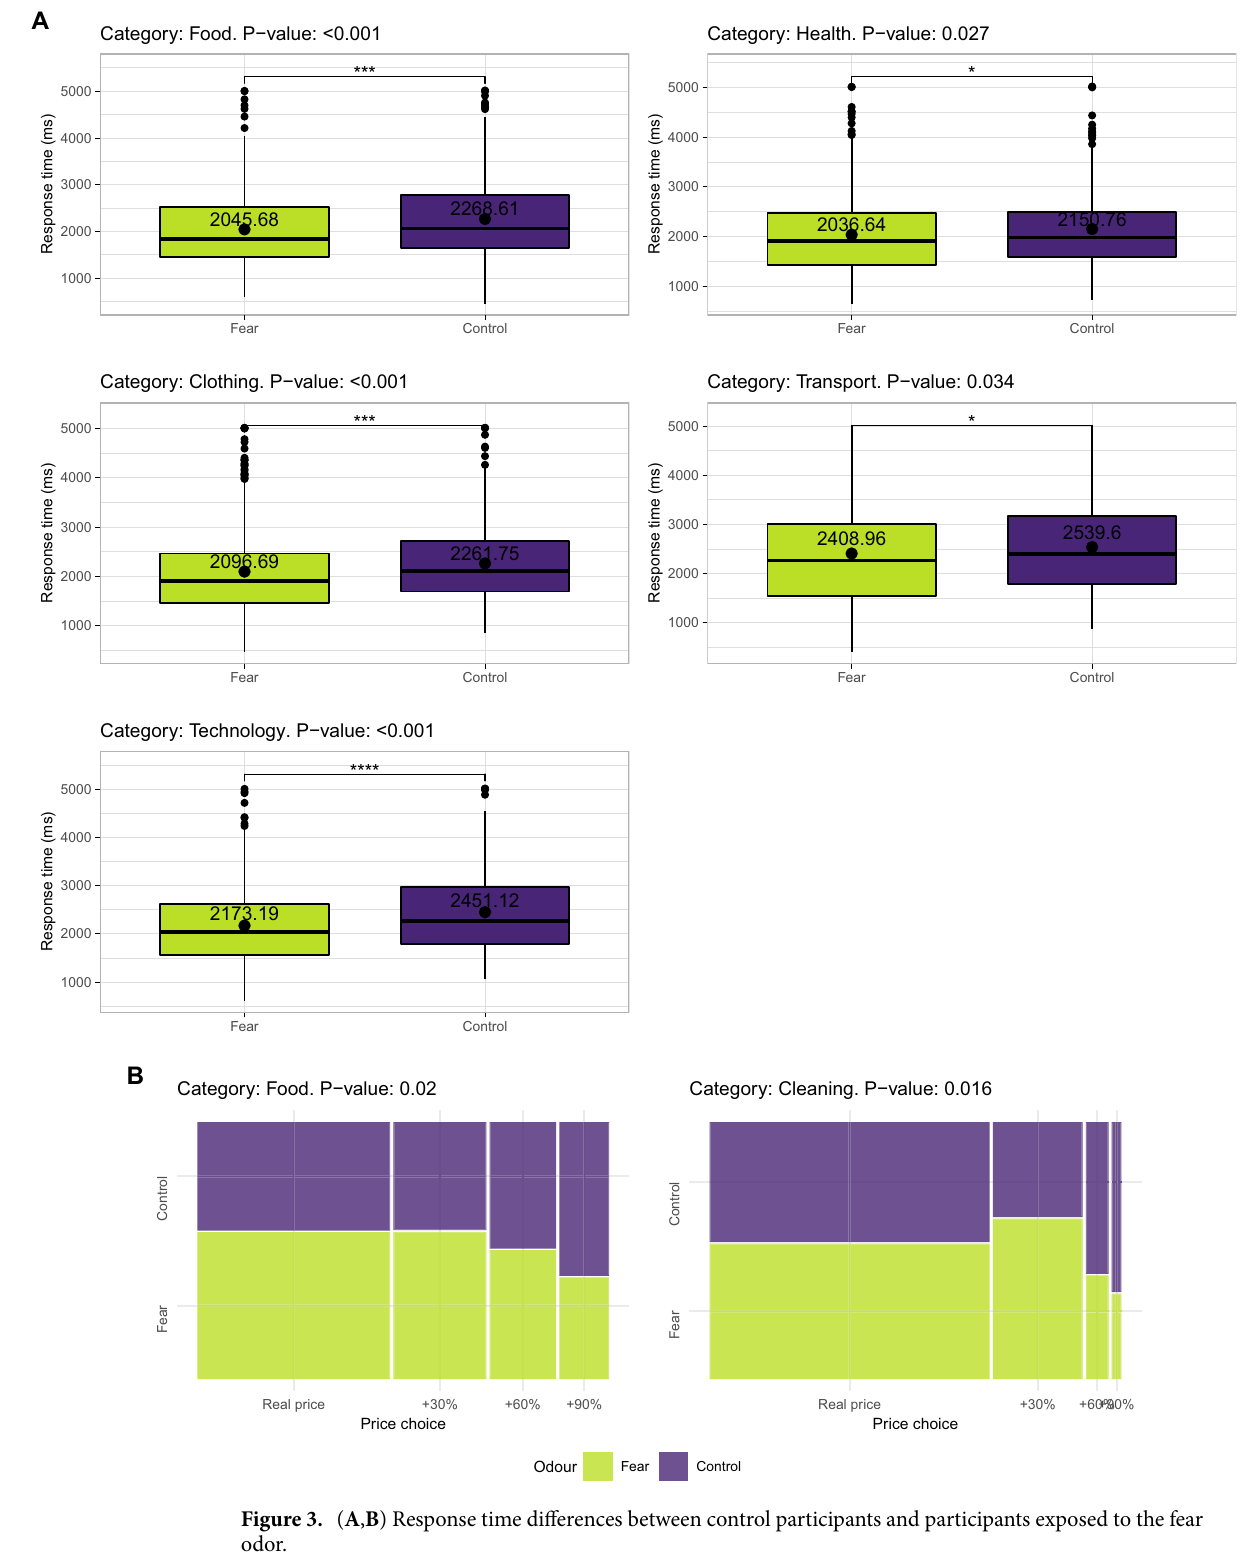
Figure 3. ( A , B ) Response time differences between control participants and participants exposed to the fear